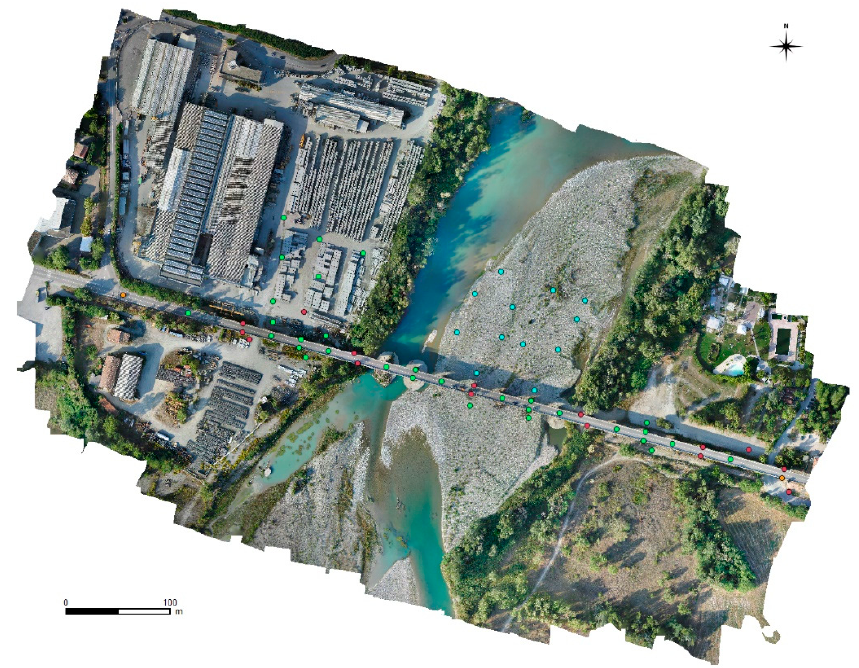
Figure 1. The surveyed area centered at (44°29 ′ 22 ″ N; 10°13 ′ 28 ″ E) with the locations of the Ground Control Points (GCP) and Control Points (CP). Targets are colored according to the test type performed (see Section 2.5). Green: always used as CP; Red: used as GCP in the test with traditional strip adjustment, CP otherwise; Orange: used as GCP in single GCP self-calibration, CP otherwise; Light blue: used as GCP in pre-calibration, CP otherwise.